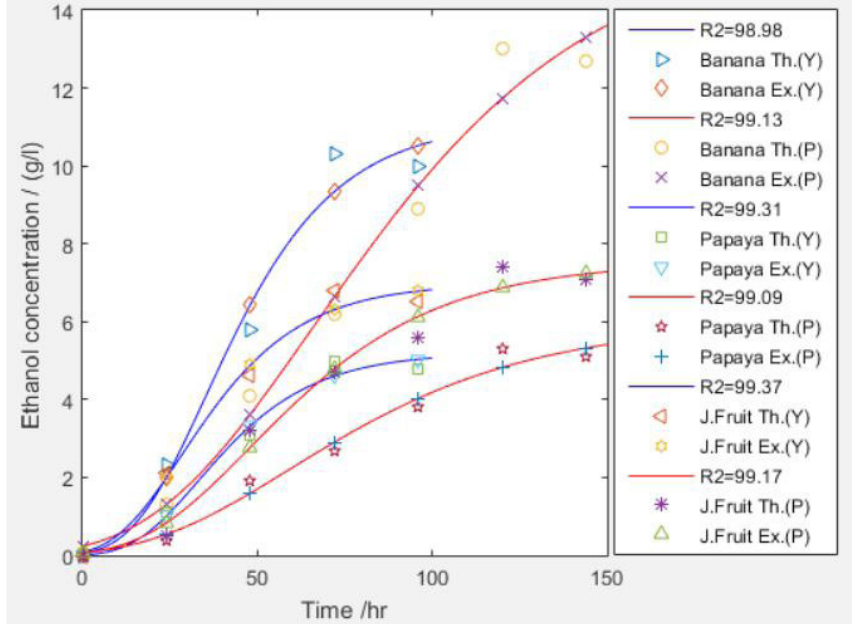
Figure 2: Variation of ethanol concentration the filtrate with time (considering the highest correlation of each fruit variety and each